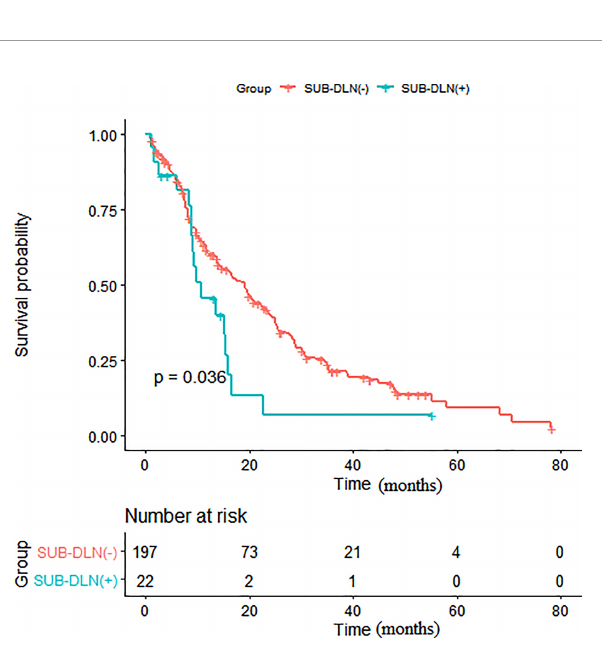
FIGURE 1 | Kaplan-Meier survival analysis of patients with and without SUB- DLN. (SUB-DLN, subphrenic distant lymph